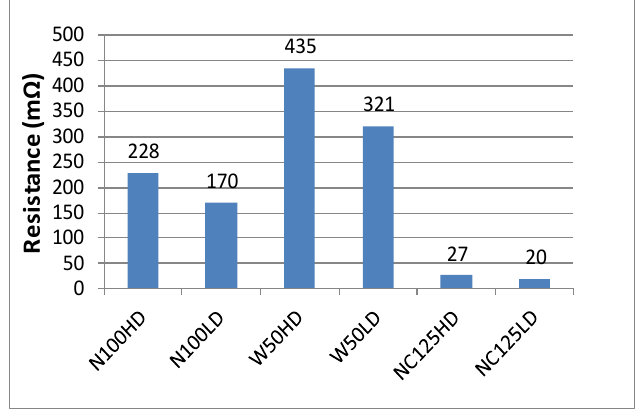
Figure 5. Sensitivity analysis; change of resistance (mΩ) for 1 °C change in